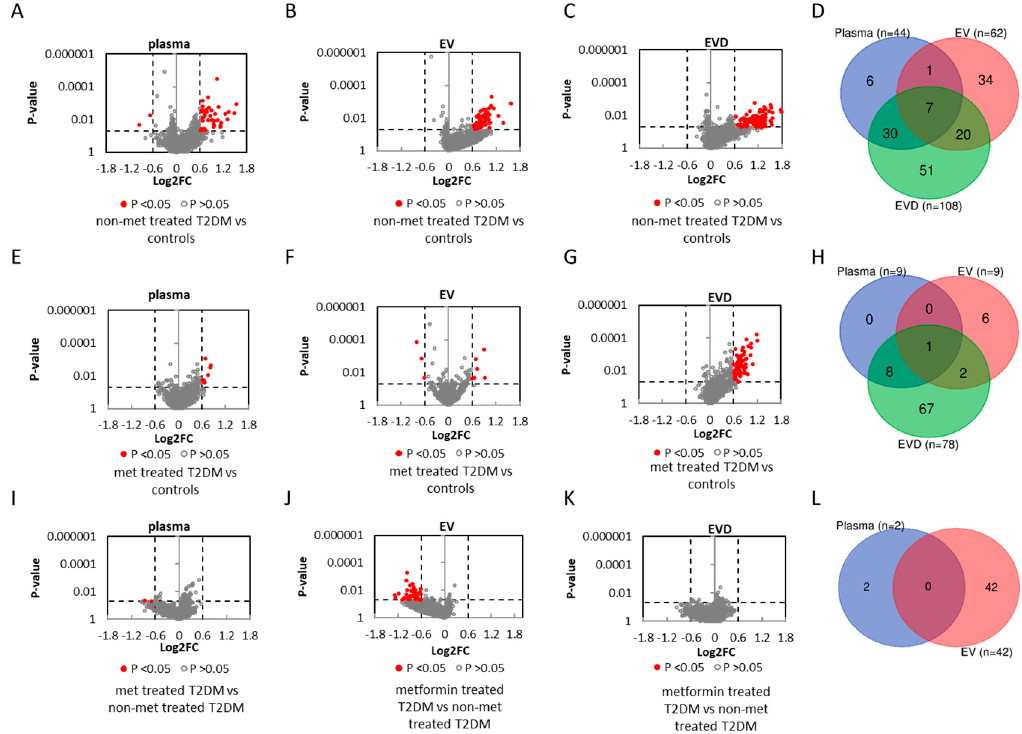
Figure 2. miRNAs with concentration changes between T2DM patients and healthy controls. ( A – C ) volcano plots for non-metformin (non-met) treated T2DM versus controls. ( E – G ) volcano plots for metformin (met) treated T2DM versus controls. ( I – K ) volcano plots for metformin treated versus non-metformin treated T2DM. Volcano plots showing miRNA log2 fold change (log2FC) versus p -value between non-metformin treated T2DM and control samples in plasma ( A ), EVs ( B ), EV-depleted (EVD) fractions ( C ), and ( D ) overlap between miRNAs that show concentration di ff erences in plasma, EVs, and EVD fractions. Volcano plots showing miRNA log2 fold change (log2FC) versus p -value between treated T2DM and control in plasma ( E ), EVs ( F ), EVD fractions ( G ), and ( H ) overlap between miRNAs that show concentration di ff erences in plasma, EVs, and EVD fractions. Volcano plots showing miRNA log2 fold change (log2FC) versus p -value between metformin treated T2DM and non-metformin treated T2DM in plasma ( I ), EVs ( J ), EVD fractions ( K ), and ( L ) overlap between miRNAs that show concentration di ff erences in plasma, EVs, and EVD fractions. Grey unfilled circles represent miRNAs with a p -value > 0.05, and red circles represent miRNAs with a p -value < 0.05, and a log2FC > ± 0.60 (fold change greater than 1.5).